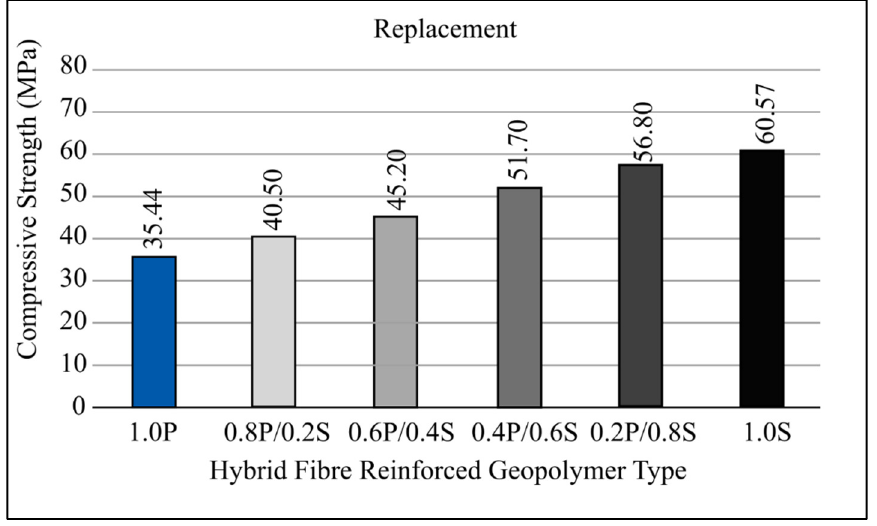
Figure 4. Compressive strength of r-HyFRG [5].